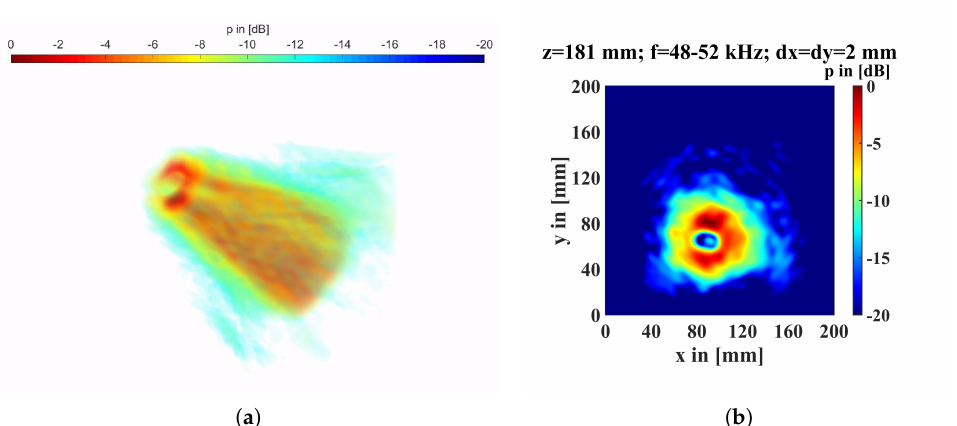
Figure 5. ( a ) Back propagated amplitude pressure field of several planes in a distance of 1 mm. At the rigth side is the measuring plane, and depicted at the left side is the air layer directly above the top surface of the particleboard with a 20 mm flaw. ( b ) Back propagated amplitude pressure field at the top of the particleboard with a 20 mm